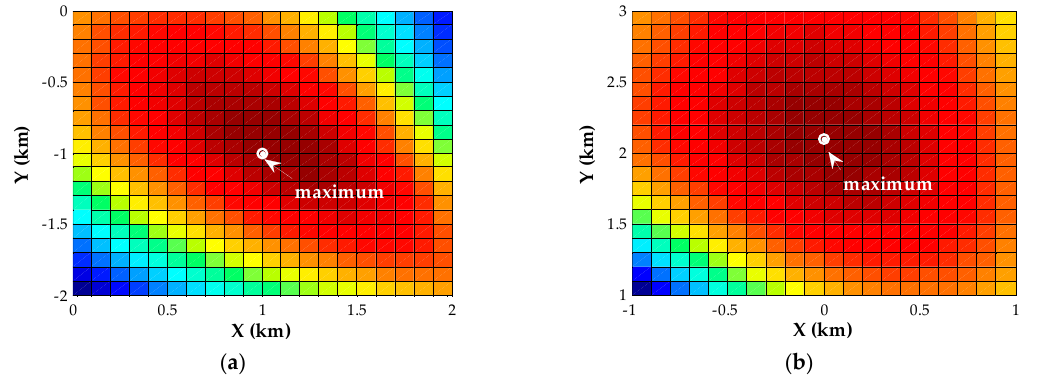
Figure 2. Evaluation of the inverse cost function over the area around the true positions of near-field sources, where different colors represent different magnitudes of amplitude. ( a ) Source 1; ( b ) Source 2.